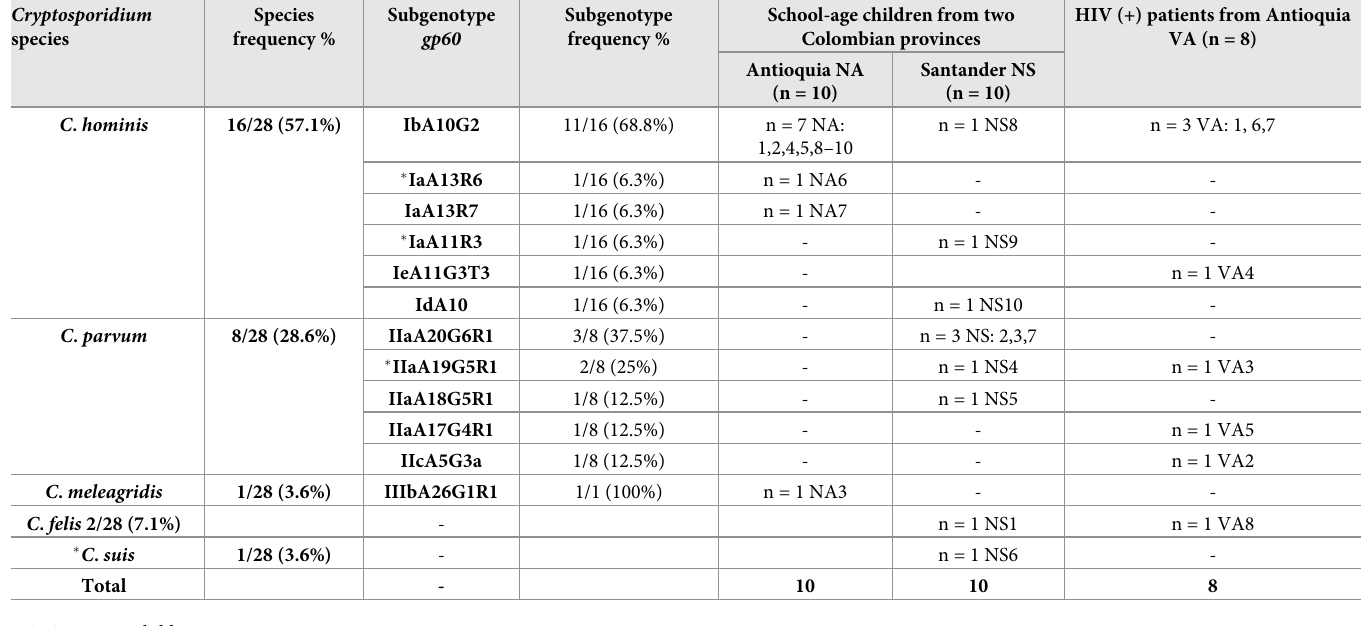
Table 1. Species identification and gp60 unilocus